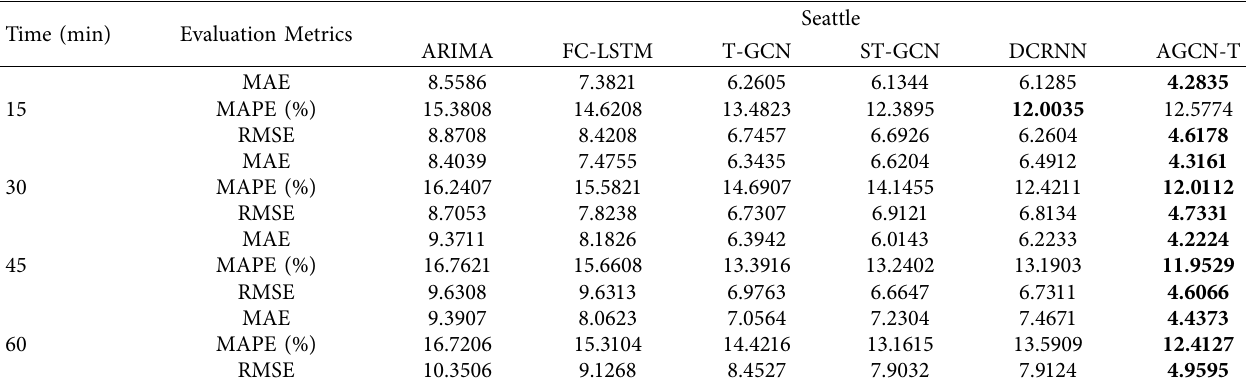
Table 4: Prediction performance of each method on Seattle.